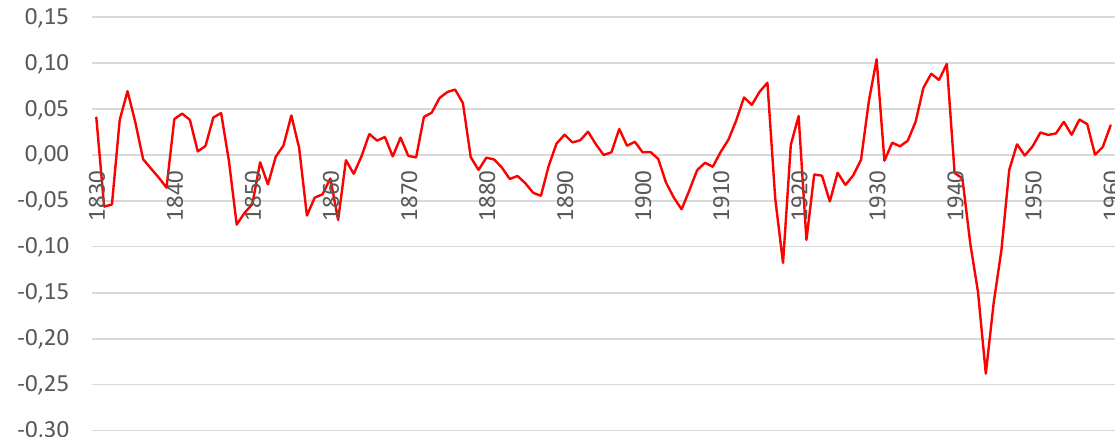
Figure 2. Norwegian business cycles, measured as output gaps,